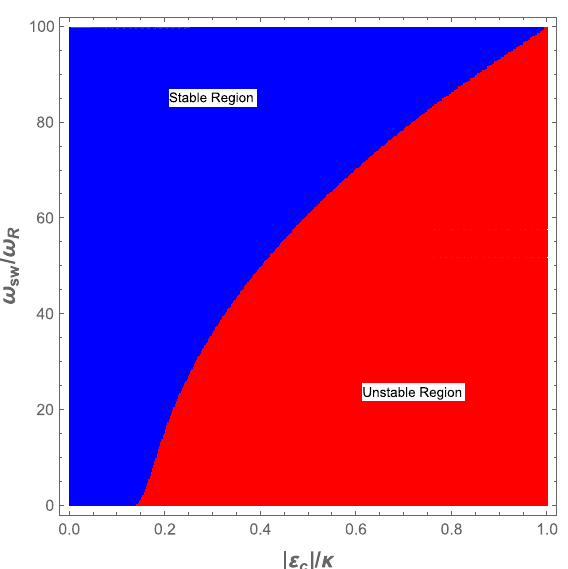
Figure 2. (Color online) The stable (blue) and unstable (red) regions, derived from the Routh-Hurwitz criteria where the horizontal axis is the normalized coupling laser pumping rate ( | ε c | /κ ) and the vertical axis is the normalized s-wave scattering frequency ( ω sw /ω R ). The parameters are given in the second paragraph of section “Results and